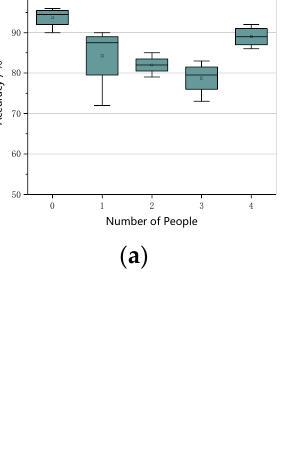
Figure 10. Accuracy of recognition of different categories: ( a ) different number of adults; ( b ) differ- ent number of children; ( c ) position when a single person; ( d ) comparison of persons and dolls.